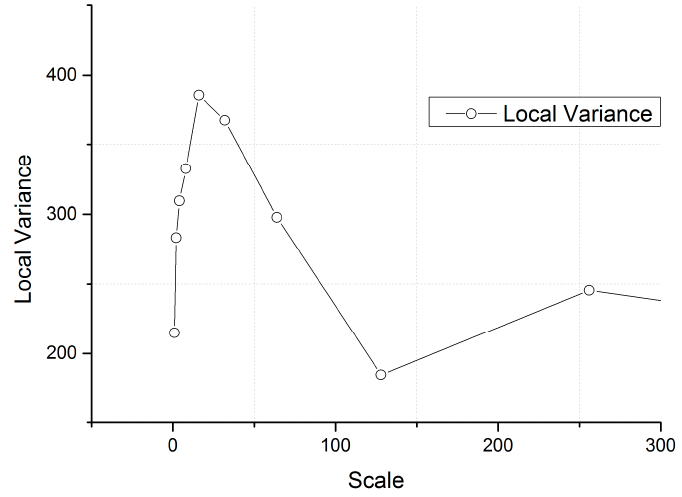
Figure 8. Local variance graph showing the multi-scale structure of UV analysis results (see text for explanations of the non-linearity of the curve).